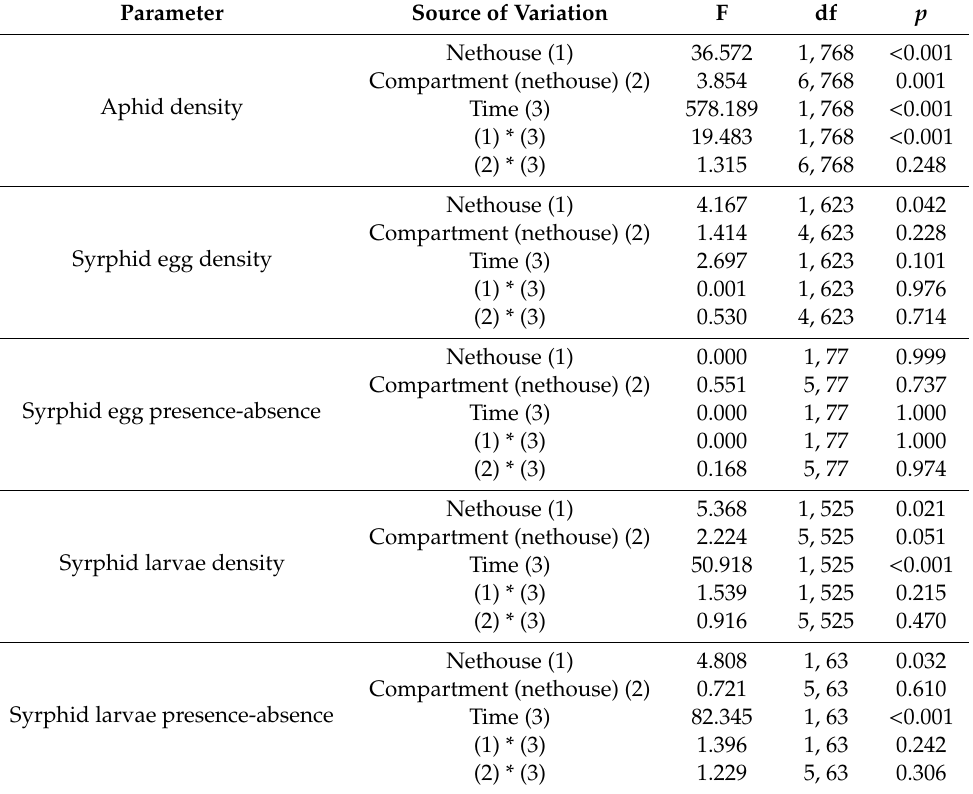
Table 1. Resume table of Generalized Linear Mixed Models (GLMM) models. Density and presence–absence data were adjusted to a Poisson and a Binomial model,